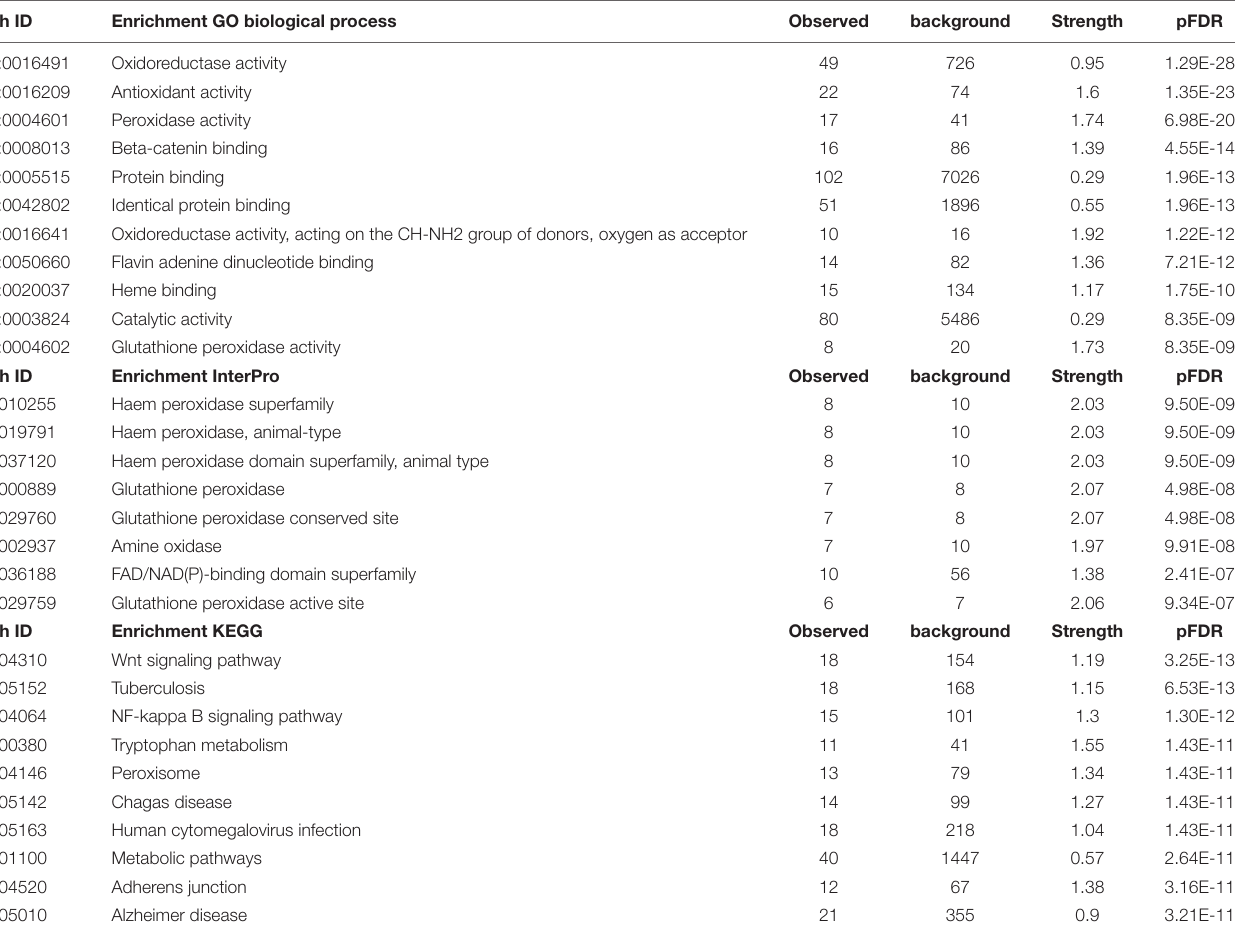
TABLE 4 | The gene ontology (GO) biological process terms, InterPro domains, and the kyoto encyclopedia of genes and genomes (KEGG) pathways associated with chronic fatigue spectrum